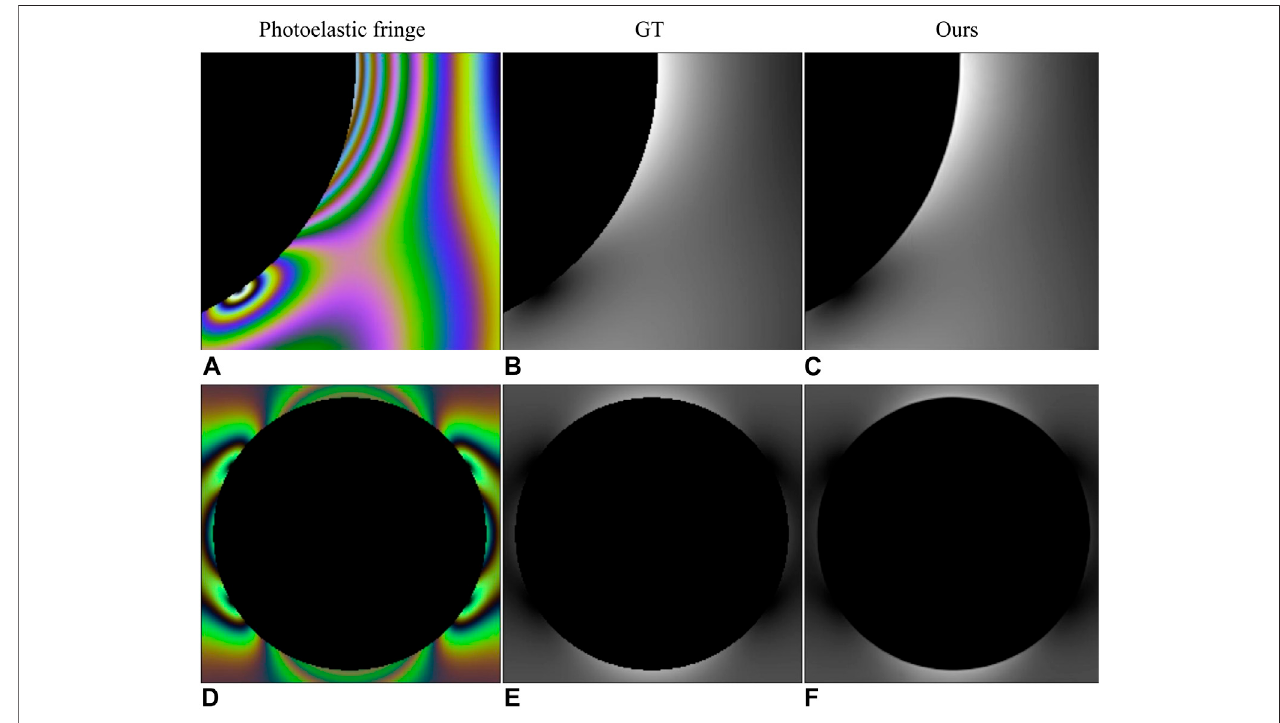
FIGURE 9 | Edge of the stress map. Photoelastic fringes (A,D) and corresponding stress maps (B,E) are selected from the test set (Briñez-de León et al., 2020e). (C,F) are stress maps recovered by the proposed method. (A) is obtained by the human vision camera sensor with a cold white laser as the light source, and the maximum stress value of (B) is 72 MPa. (D) is obtained by a Sony_IMX 250 camera sensor with Willard_LED as the light source, and the maximum stress value of (e) is 48 MPa.